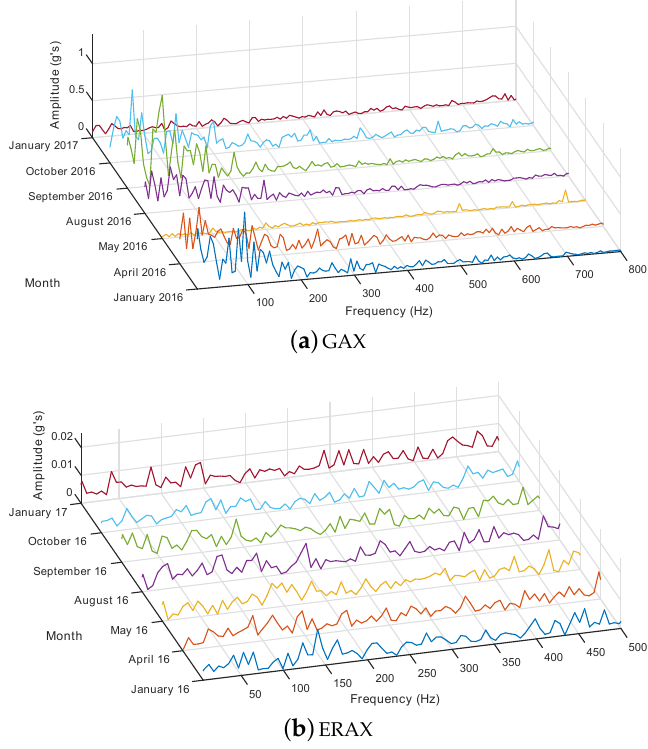
Figure 6. January 2016–January 2017. Evolution of envelope spectra at super-synchronous speed.